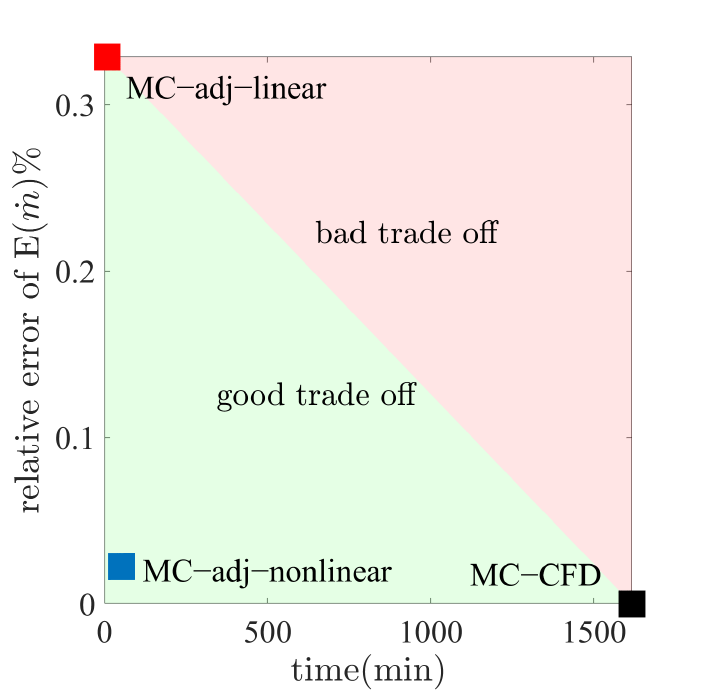
Figure 15. Time cost versus accuracy in calculating the mean mass flow rate at the design condition using the three